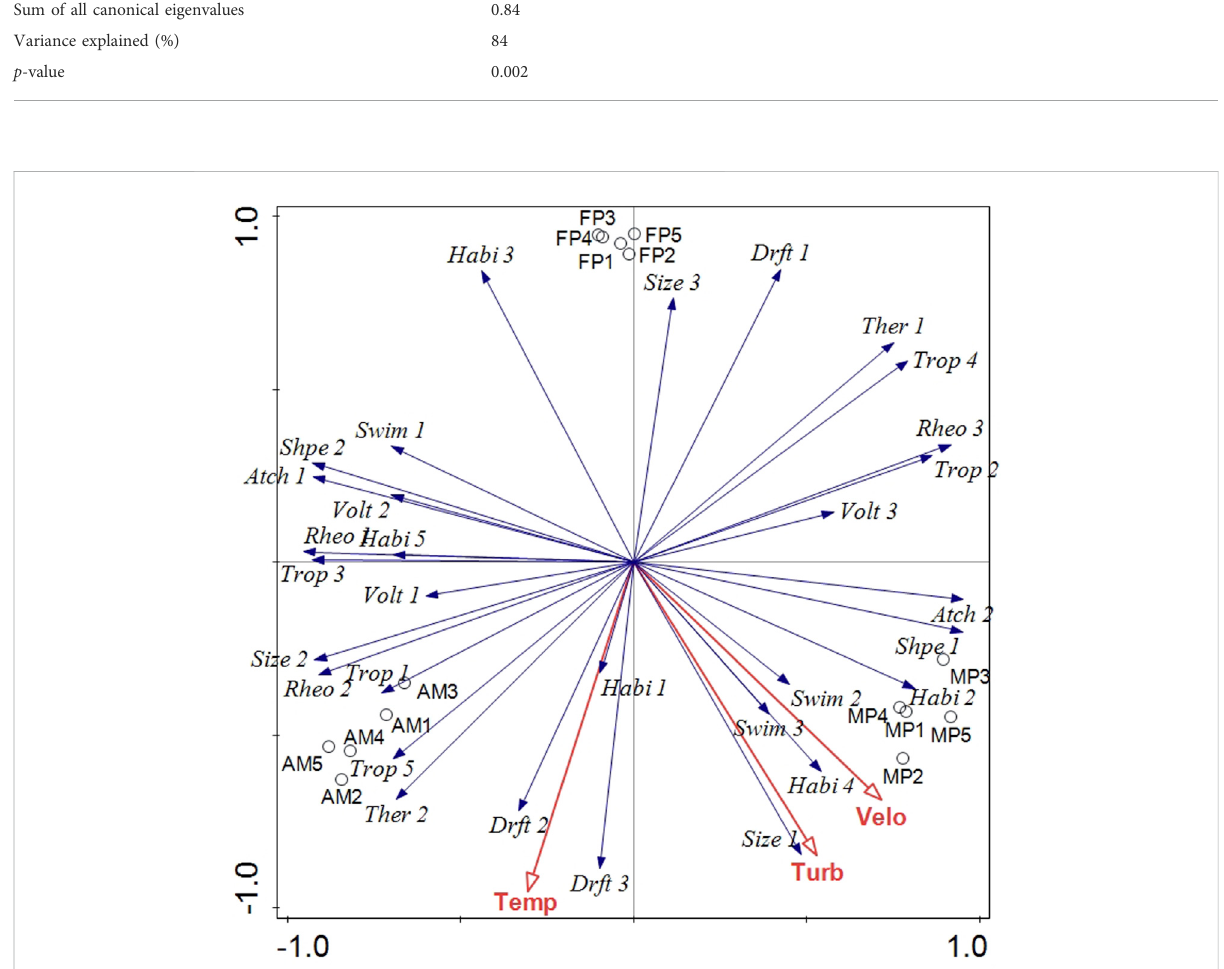
FIGURE 6 Redundancy analysis (RDA) ordination biplots of functional traits (blue arrows), sampling sites (black circles), and forward-selected environmentalfactors(redarrows)forthreeperiodsofmeltingiceandsnow.ThesummaryofordinationresultsispresentedinTable1andthecodes for each functional trait category are shown in Supplementary Table S1. Temp, Temperature; Turb, Turbidity; Velo, Velocity. FP, freezing period; MP, melting period; AM, after the melting